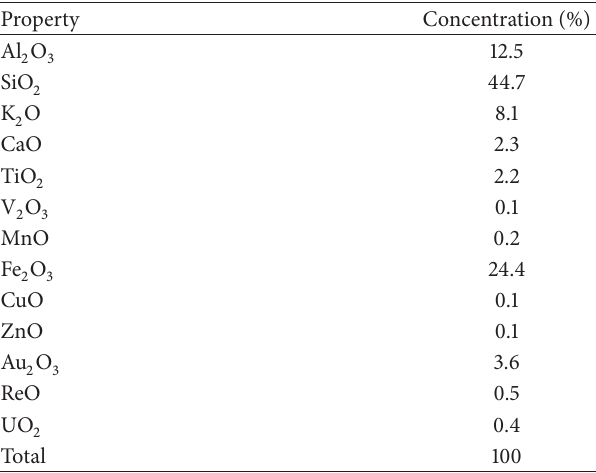
Table 3: Chemical composition of the